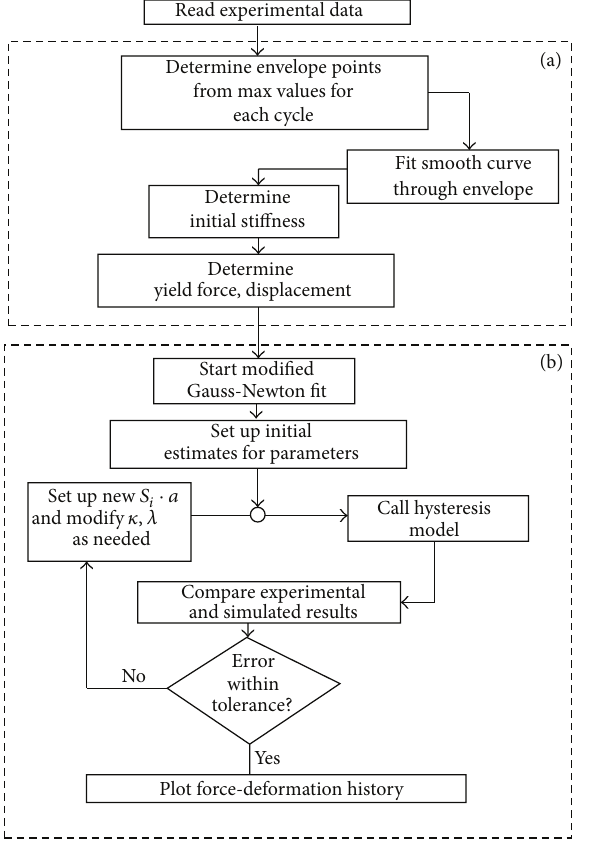
Figure 2: Flow diagram for complete identification process [5].